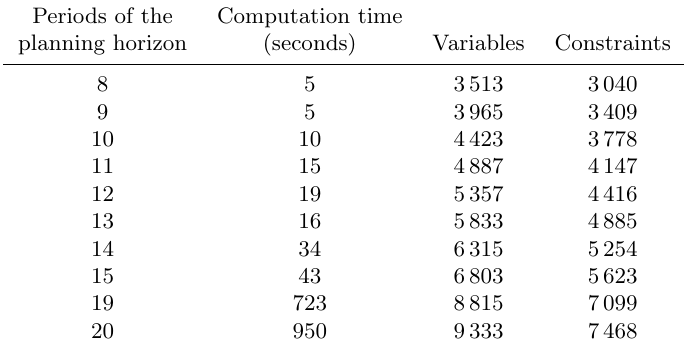
The computational times, number of variables and number of constraints associated with each planning horizon